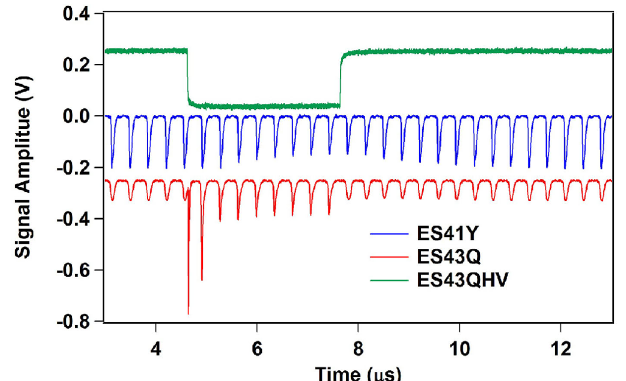
FIG. 13. (Color) Evidence for seeding of the drift space region by electrons ejected from the quadrupole ( 10 = 16 = 07 ). The green curve (ES43QHV) is an attenuated signal from the (cid:5) 485 V pulse applied to the sweeping electrode in the quadrupole. The corresponding collector signal from the quadrupole is the red curve (ES43Q). The blue trace is the prompt signal from the ES41Y detector in the adjacent drift space. Note the (cid:1) 25% reduction in the ES41Y signal after about 8 turns with the sweeping electrode energized followed by recovery after the electrode is deenergized.